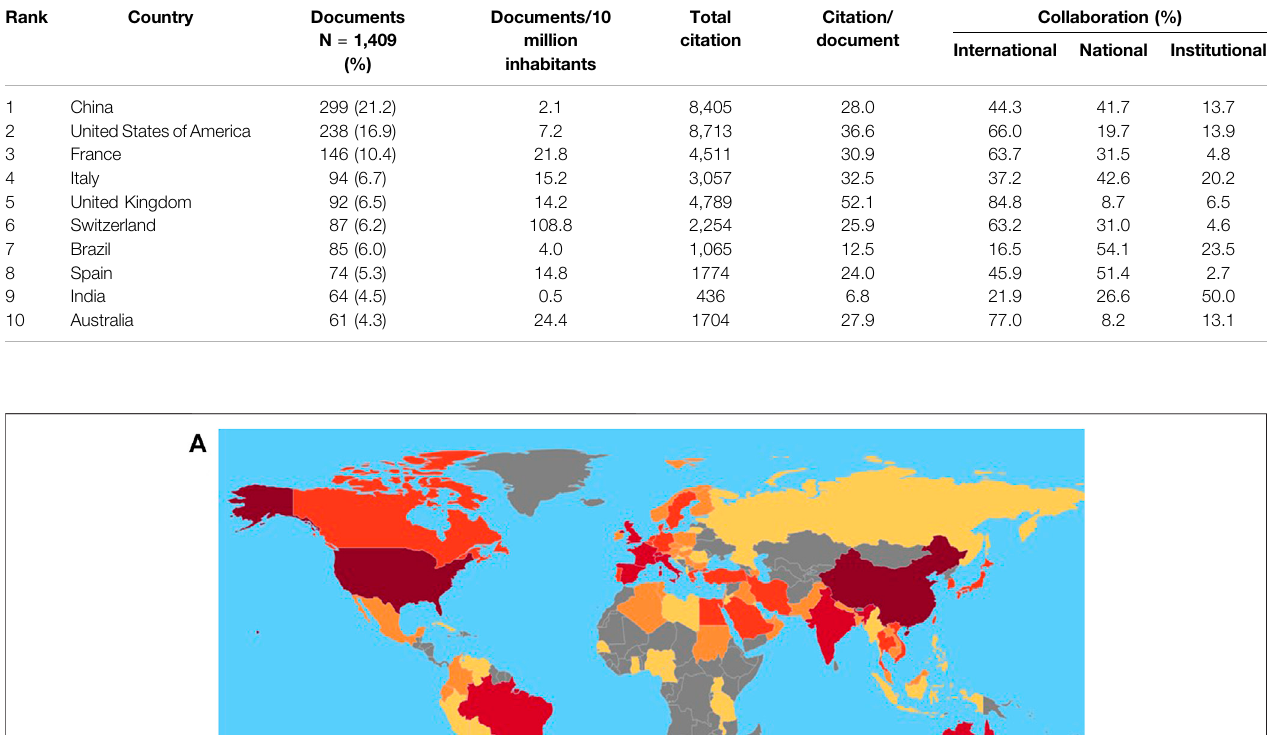
TABLE 2 | Top ten productive countries on polymyxin resistance (2010 – 2019).